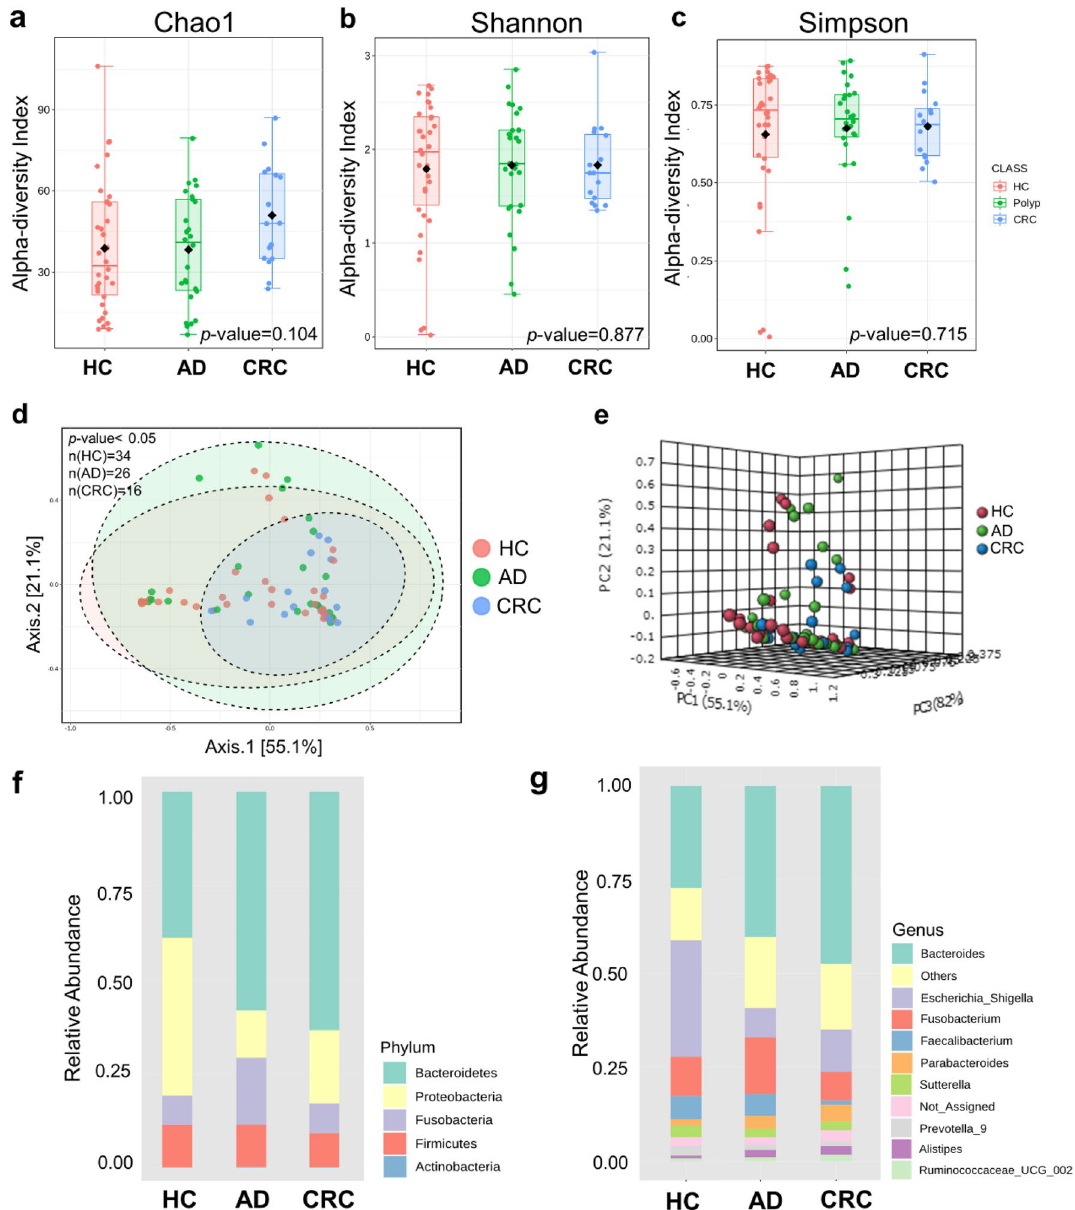
Figure 1. Microbial diversity analyses and microbial abundance profiling in mucosal tissue samples among healthy control (HC), adenoma (AD), and colorectal cancer (CRC) subjects, ( a ) Chao1’s index, ( b ) Shannon’s index, ( c ) Simpson’s index, ( d ) Principal Coordinate Analysis (PCoA) analysis based on Bray–Curtis distance in 2–Dimension, ( e ) PCoA analysis based on Bray–Curtis distance in 3–Dimension, (f ) Taxonomic composition type at the phylum level, ( g ) Taxonomic composition at the genus